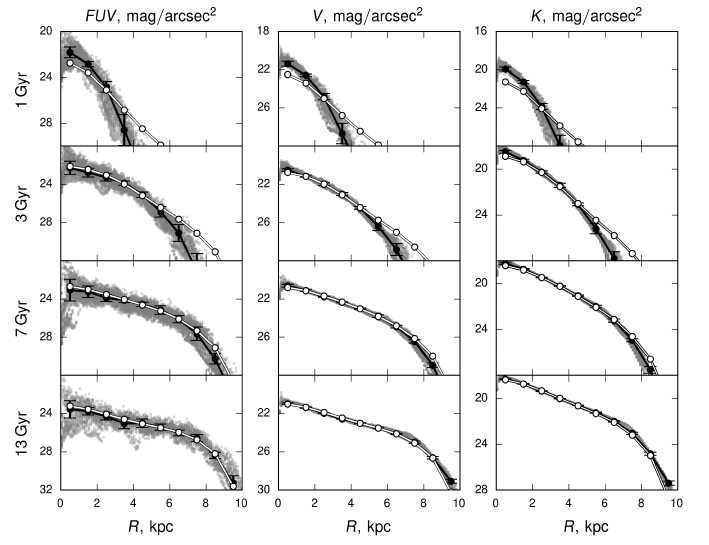
Fig. 10. The same as in Fig. 9, but for the HS